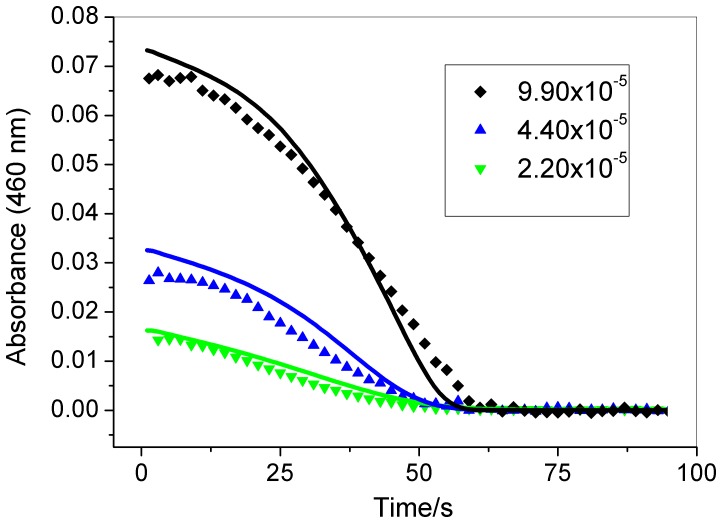
Effect of iodine concentration (indicated in the figure – mol L−1) in the clock time.Other initial concentrations: [HClO4] = 0.948 mol L−1; [NaClO3] = 0.0251 mol L−1; [HNO2] = 1.15×10−3 mol L−1. Experimental (symbols); simulation (continuous lines). Experimental data point were measured at every 2 s.